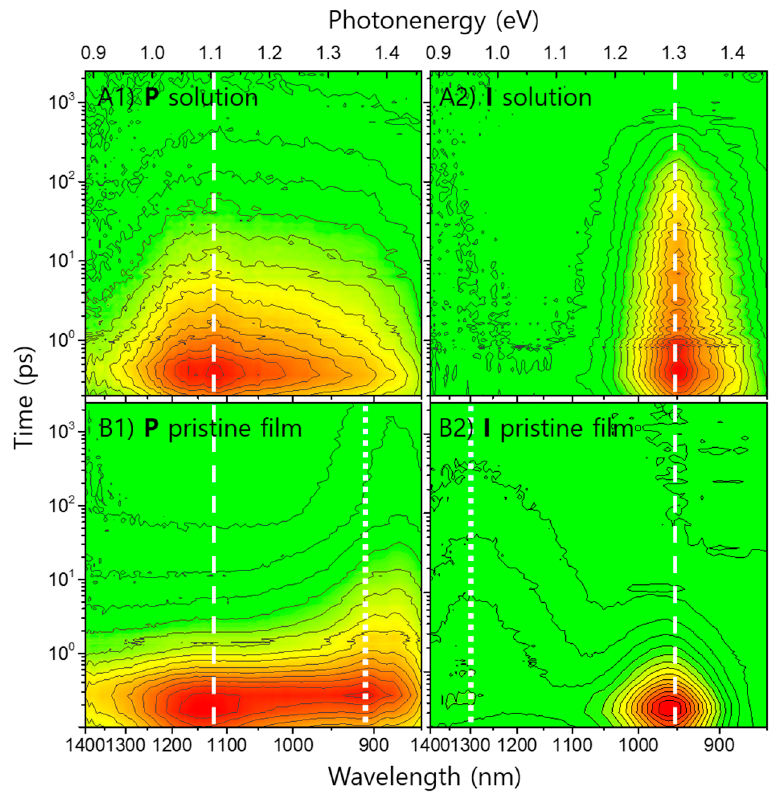
Figure 2. IR range TA spectra of ( A1 ) P solution, ( A2 ) I solution, ( B1 ) P pristine film, and ( B2 ) I pristine film. The excitation wavelength is 575 nm. The ∆ OD intensities are mapped with linear-scale contour lines combined with color assignment from positive values (red) to zero (green). Additional white dashed and dotted lines mark significant TA band positions.